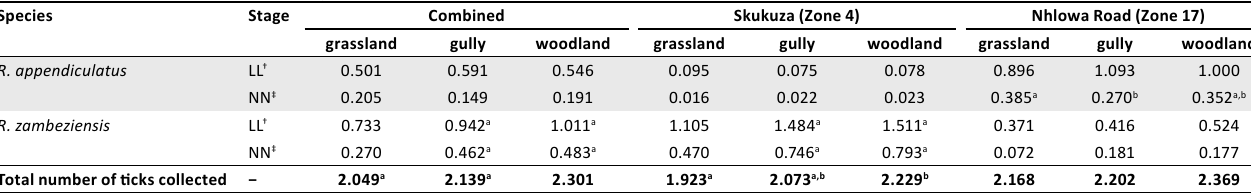
TABLE 2: Mean monthly tick collections [log